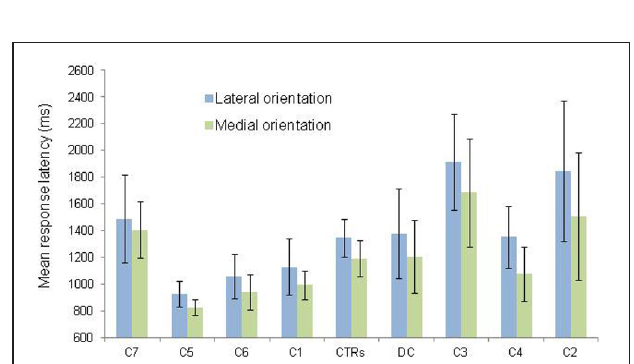
FIGURE 3 | Mean response latency and standard deviation (vertical bars) are shown as a function of hand orientation (lateral vs. medial). The data for the lateral and medial orientation were obtained by pooling the data from all postures and rotation angles corresponding to the lateral (blue) and medial (green) positions depicted in Figure 1 . Individual data (C = Control; CTRs = mean of controls) are aligned in ascending order on the X axis as a function of the size of the medial over lateral